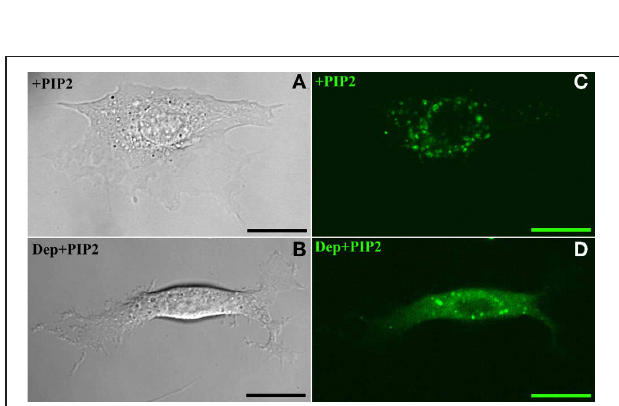
FIGURE 4 | Exogenous PIP2 localization. Panels on the left and right, respectively, refer to images acquired with Differential Interference Contrast and confocal microscopy. (A,C) PIP2-loaded BAEC. (B,D) Cholesterol-depleted BAEC loaded with exogenous PIP2. Scale bars: 20 μ m.